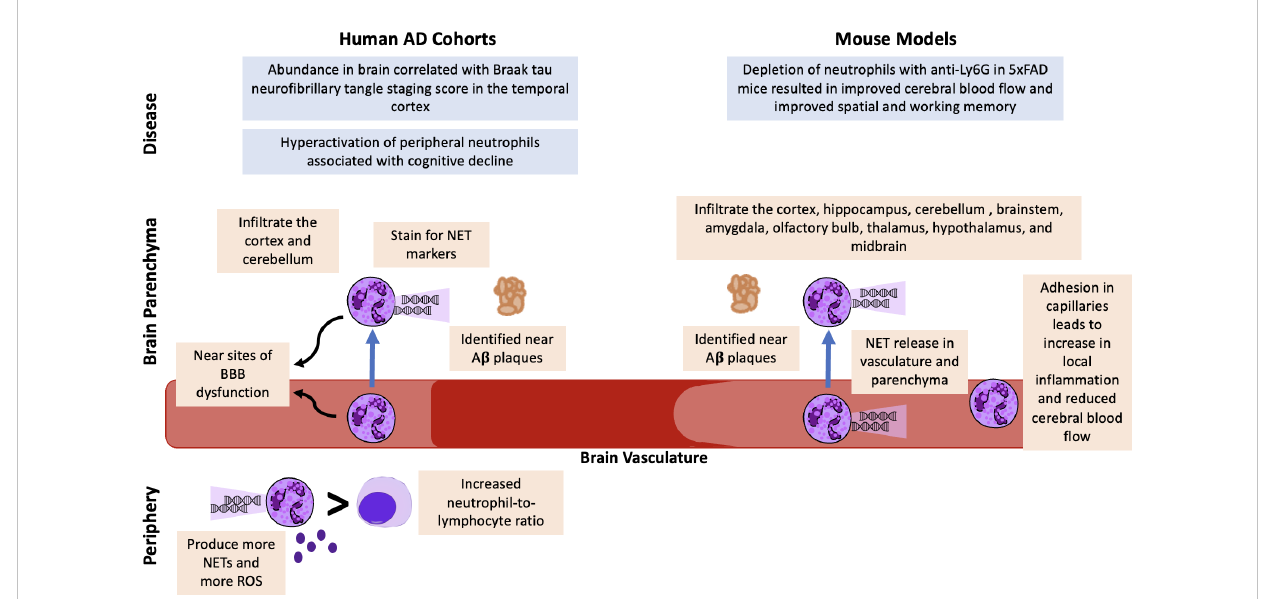
FIGURE 1 Potential Neutrophil Involvement in AD from Human AD Cohorts and AD Mouse Model Studies. Neutrophils have been identi fi ed in the brain vasculature and parenchyma in human cohorts and mouse models of AD. In both humans and mice, neutrophils are found near A b plaques and stain for NET markers. Neutrophils have been associated with BBB dysfunction, and mouse models suggest they also contribute to reduced cerebral blood fl ow. An increased blood neutrophil-to-lymphocyte ratio and increased neutrophil activation, NET release, and ROS release have been identi fi ed as potential peripheral markers of AD. Finally, correlative analyses in humans have demonstrated associations with brain neutrophils and Braak staging and hyperactivation of peripheral neutrophils associated with cognitive decline. Mechanistic studies in mice demonstrated